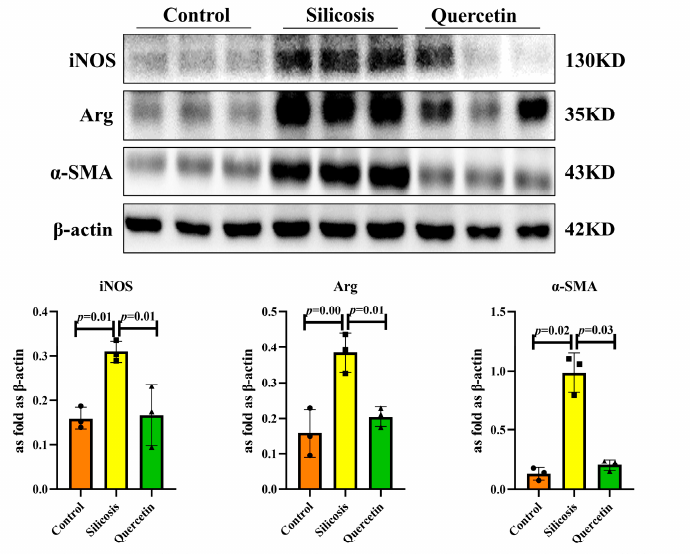
Figure 4. The expressions of iNOS, Arg, and α -SMA in the lungs, measured by Western blot. Data are presented as mean ± SD, n = 3 per group.